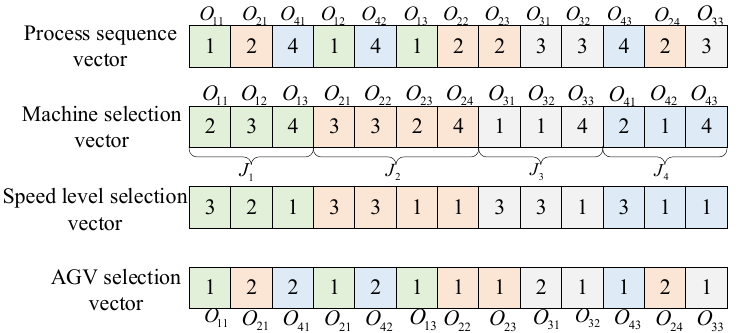
Figure 3. The encoding form of a scheduling solution.